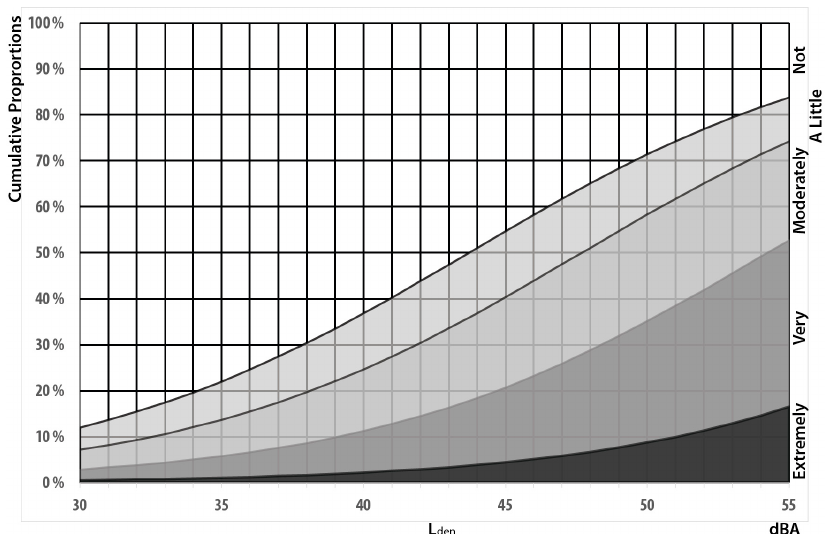
Figure 12. Exposure–effect relationships for annoyance from wind turbine noise outside dwellings for residents who are indifferent or do not agree with the statement that Norway should rather prioritize hydropower ( n = 87).